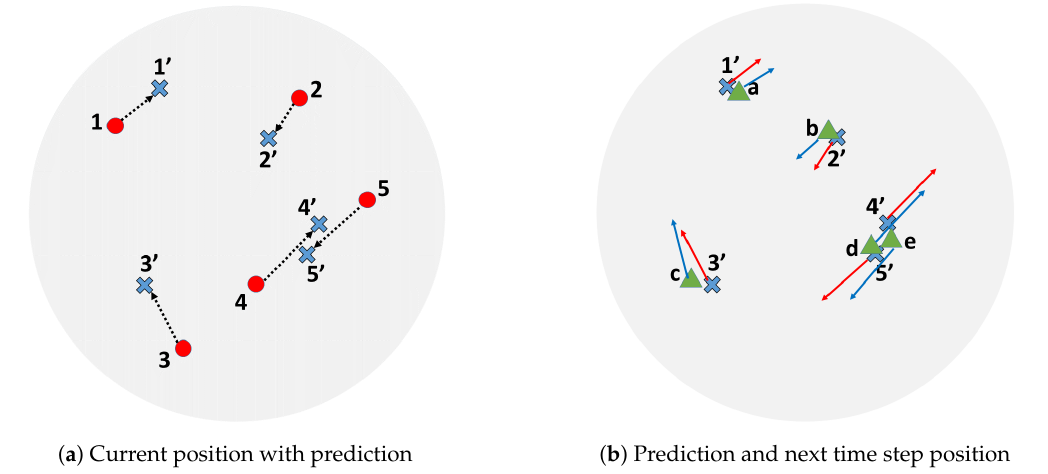
Figure 9. Tracking process overview. The first position of each fly in the next time step is predicted by using its current position shown in red dots and current velocity shown in the dotted vector. Next, detected positions in the next time step are paired with the predicted positions by using the Hungarian assignment algorithm. The result of pairing is confirmed by checking the heading directions. The system rejects the pair that has a high direction difference. In this figure, the pairs {4 (cid:48) , e } and {5 (cid:48) , d } will be rejected and refined with the closest neighbor assignment